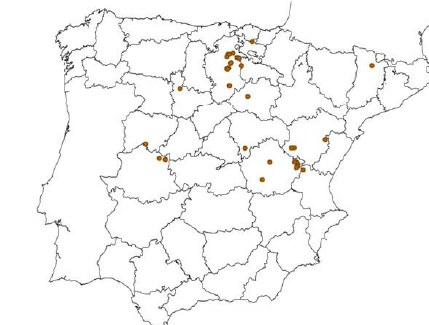
Figure 5. Geographical distribution of analysed half-timbered walls with monolithic infills.